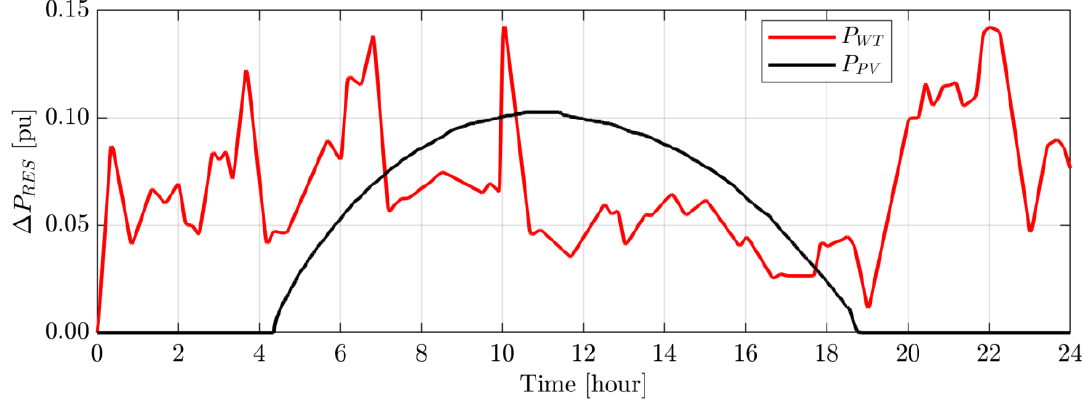
Figure 19. Wind and solar PV power profiles for long-term study for the scenario C.